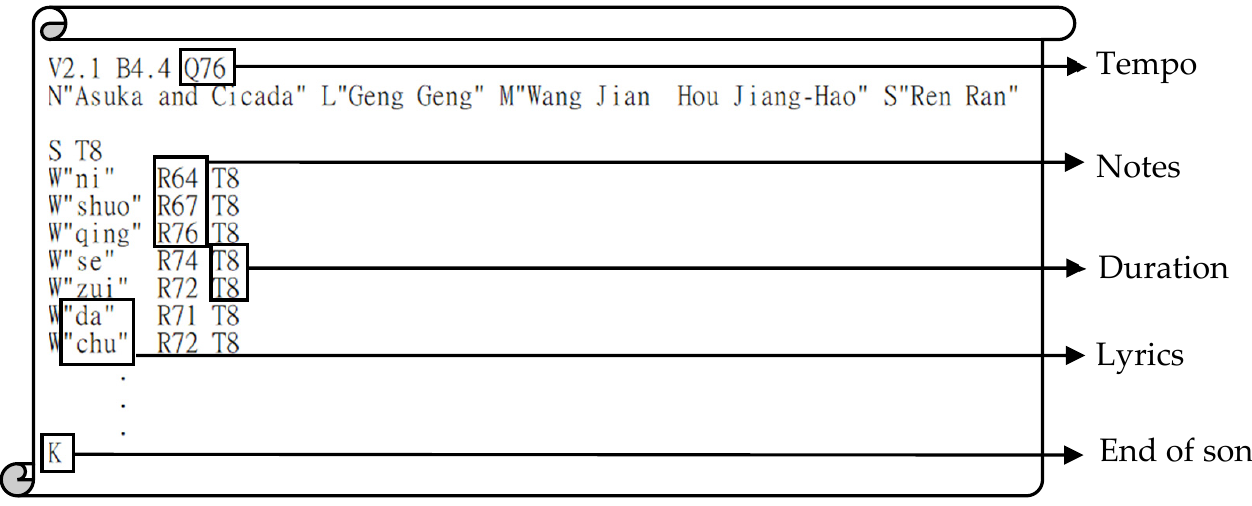
Figure 5. The Nutext format example.